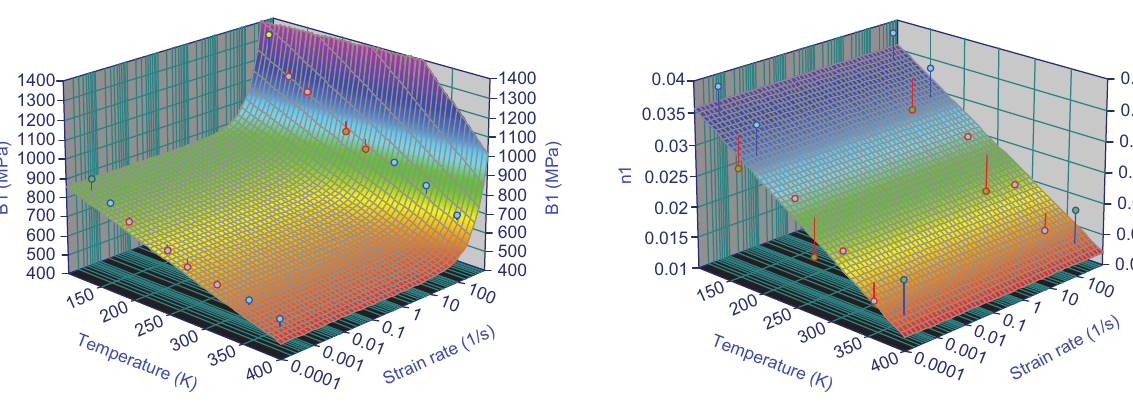
vs. temperature and 1